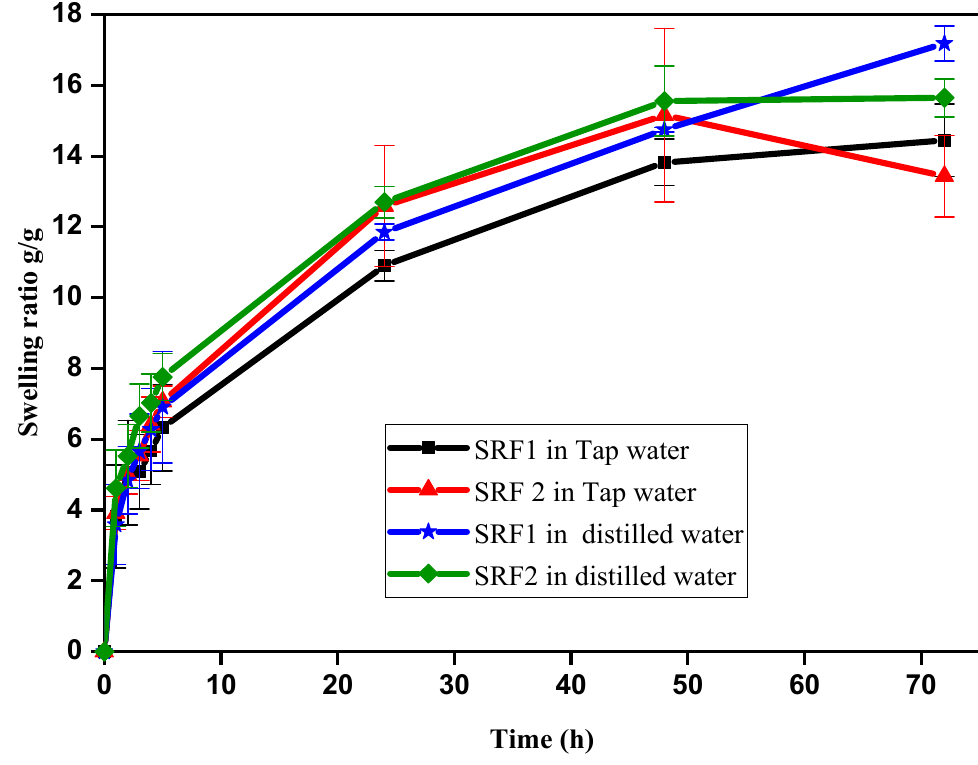
Figure 4. Swelling behaviors of hydrogels in solution .